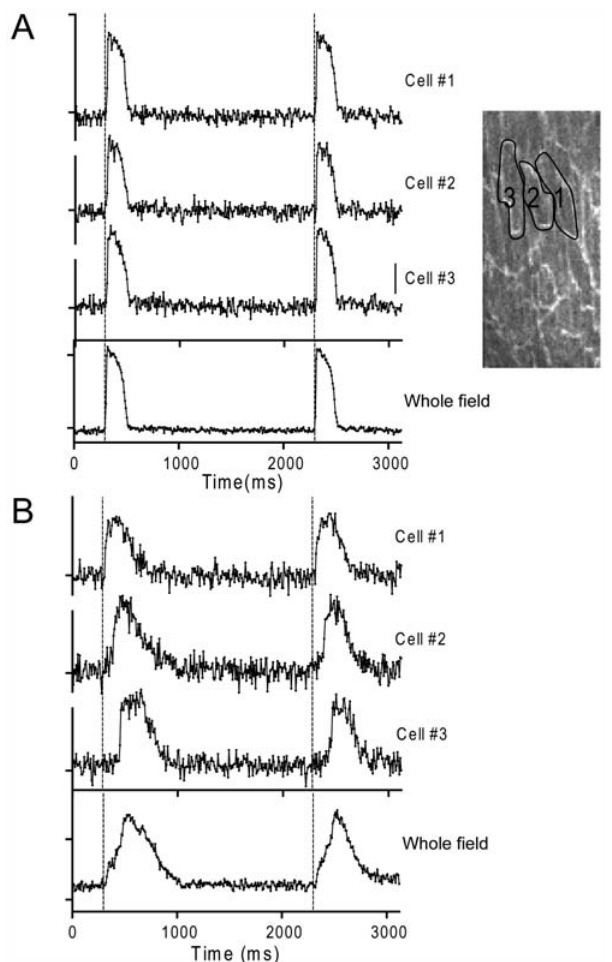
Figure 4. Action potential signals in the presence and absence of heptanol. A. Action potential signals from three adjacent cells along with the whole field of view in a control muscle. B. Action potential signals from same three adjacent cells and the whole field of view in the presence of 2 mM heptanol. In A and B , bars indicate ratio of